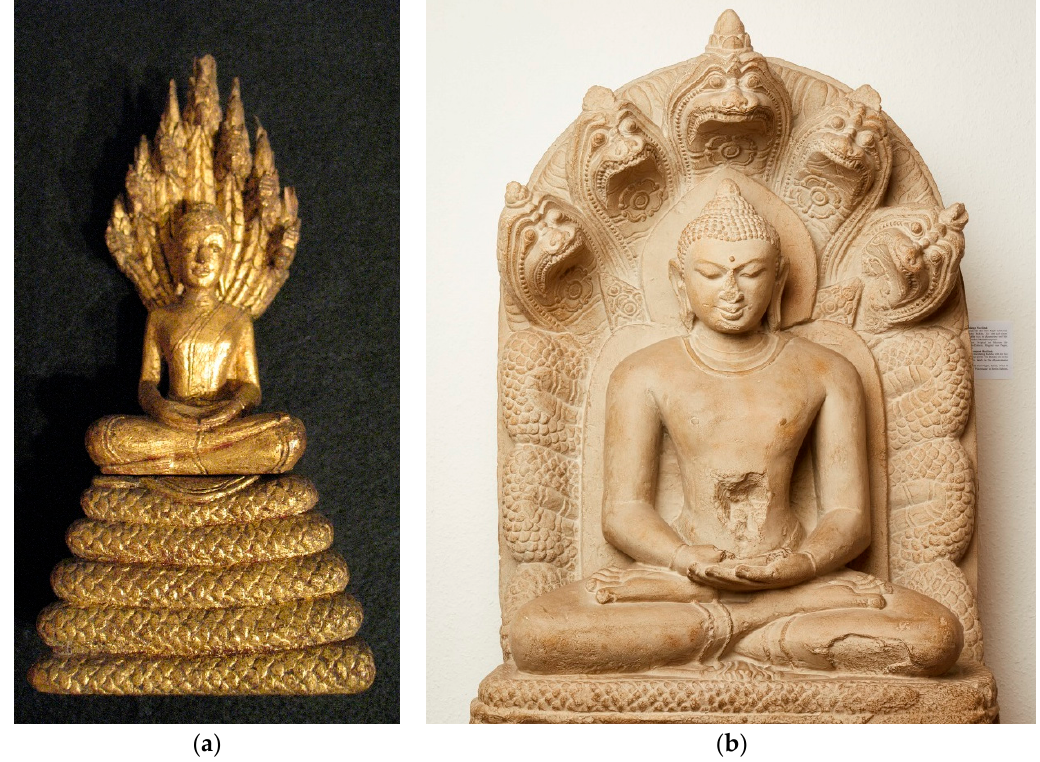
Figure 4. Mucalinda, a five- or seven-headed N ā ga king, rises like an aureole behind the Buddha, who is sitting in the lotos position ( padm ā sana ): ( a ) Brass figure from Thailand, purchased for the Marburg Museum of Religion in 1957 (photo by Heike Luu, acc.nr. Mq 027); ( b ) Gipsum replica of a Burmese figure, probably from Bagan, 11th—12th c. CE (photo by Georg Dörr, acc.nr. Mq 030; for a detailed examination on their provenience, cf. (Luu 2017)).